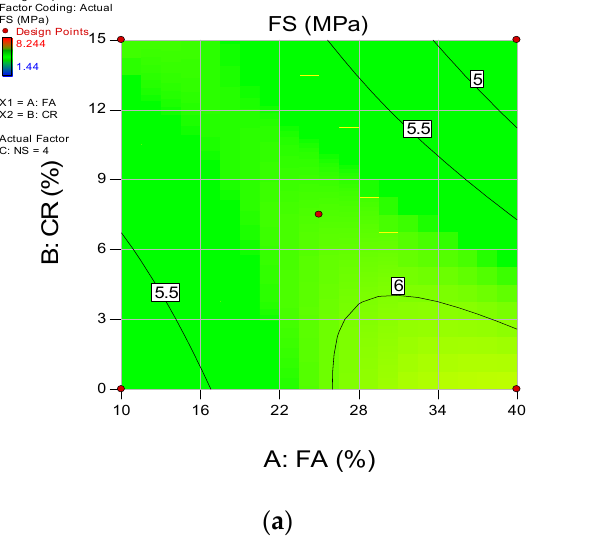
Figure 16. ( a ) 2D contour plot and ( b ) 3D response surface diagram for FS. The diagrams’ color coding represents the response’s magnitude and the varying levels of the input variables under consideration. Figure 15a,b shows the 2D contour and 3D response diagrams for compressive strength, respectively. The plots indicate a